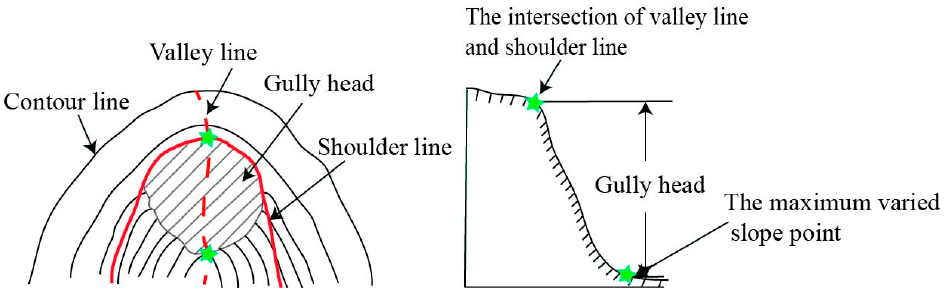
Figure 6. Illustration of the gully head location.